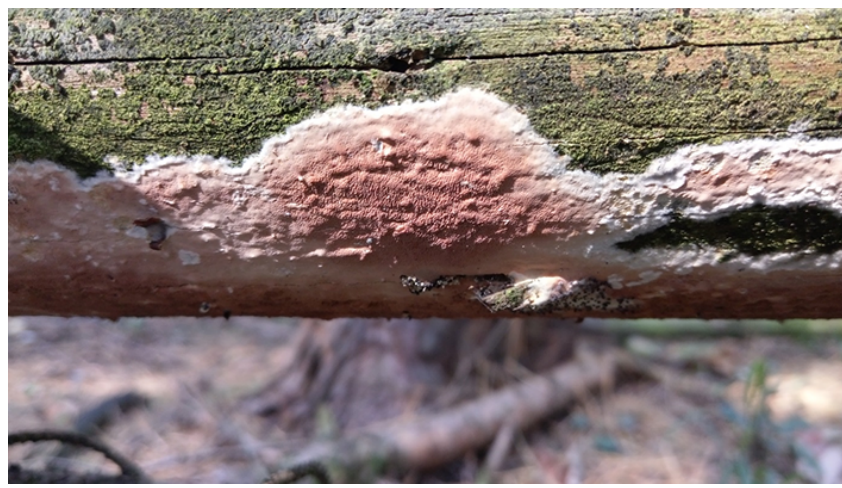
Figure 9 Basidiomata of Meruliopsis taxicola (Pers.) Bondartsev. Photography by Anna